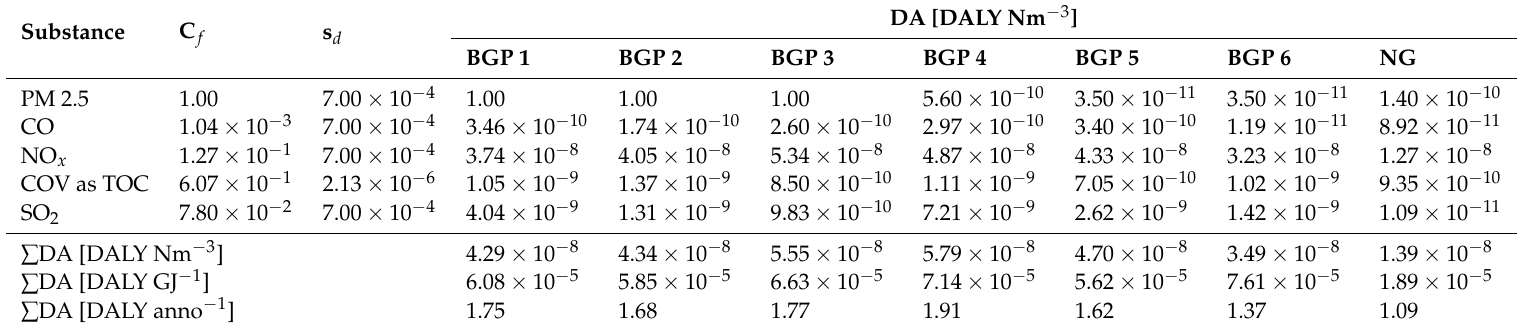
Table 17. Damage assessment for the emissions of biogas plants and the natural gas plant.